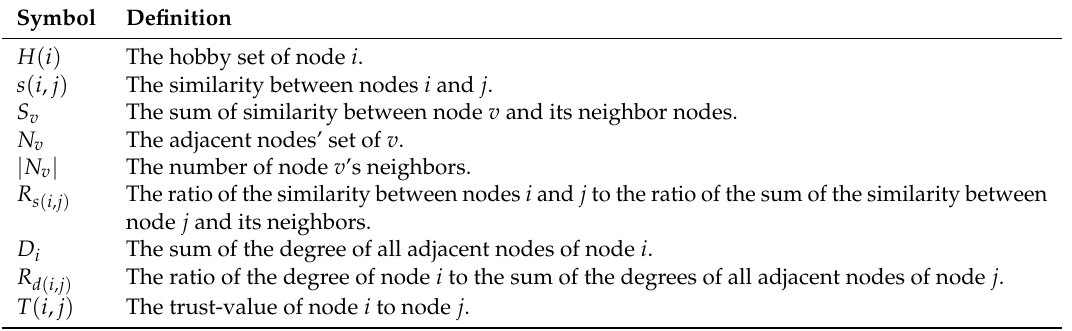
Table 1. Definitions of